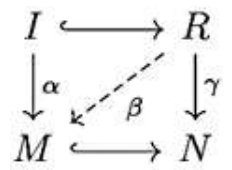
Diagram 1: Strongly principally